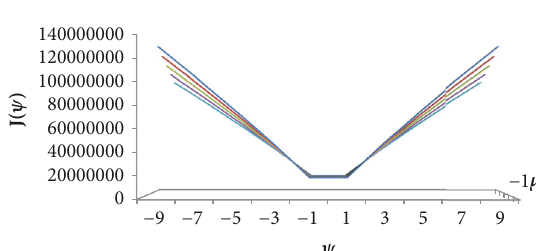
Figure 4: Graph of expected present value of the utility of asset 𝐽(𝜓) versus control 𝜓 and subjective discount rate 𝜂 while degree of relative risk 𝜆 is fixed at 0.9 .